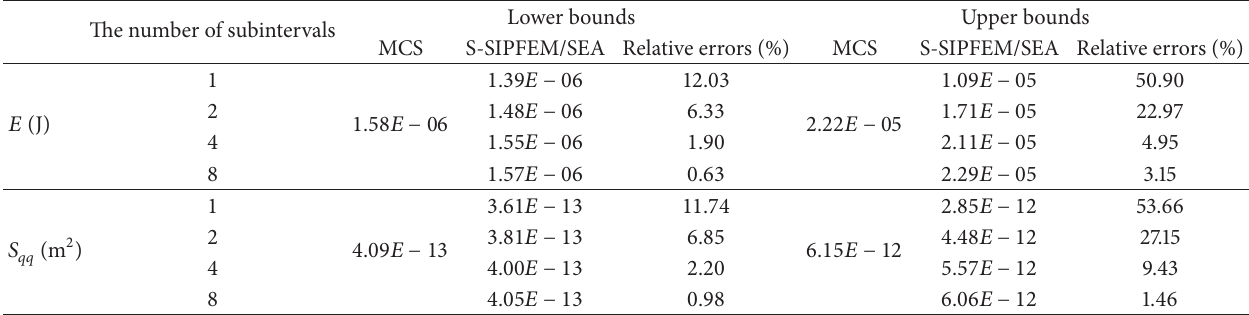
Table 4: The relative errors of the bounds of the plate energy and the autospectra of the mass displacements yielded by S-SIPFEM/SEA with different subinterval numbers ( 𝑓 = 230